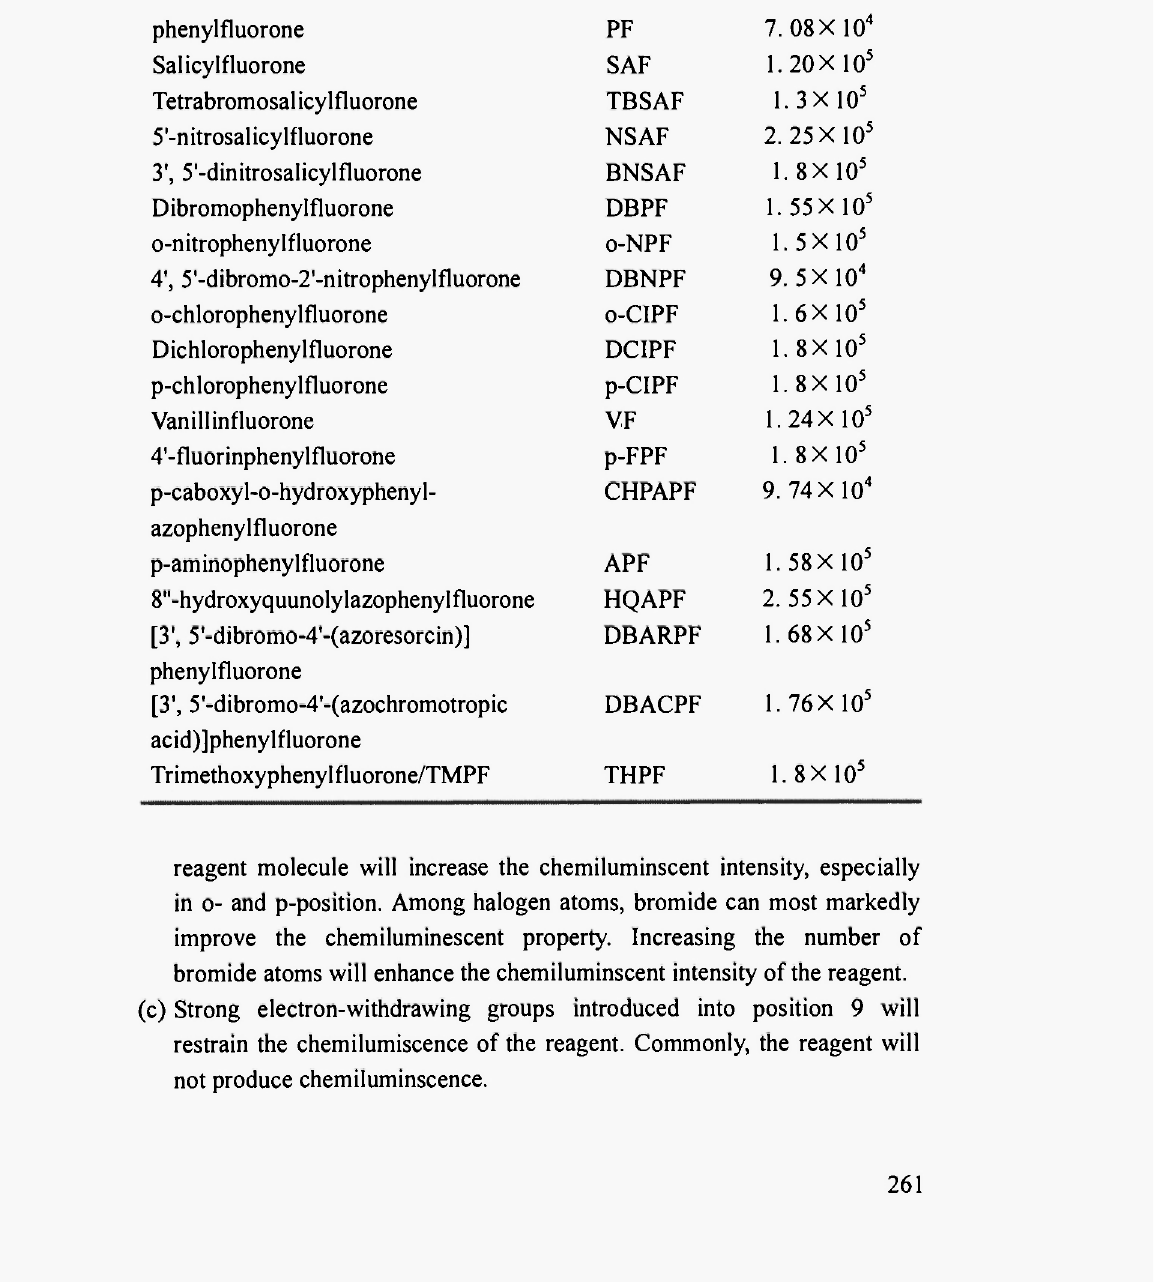
Comparison of the sensitivities of the reaction of germanium with fluorone